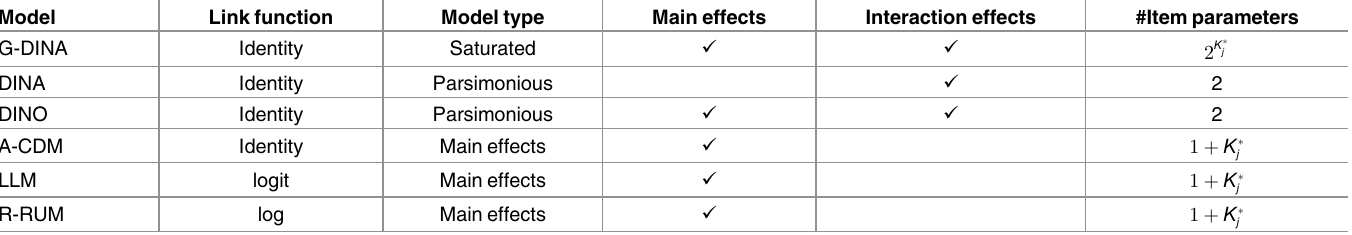
Table 4. Summaryof sub-models of G-DINA model